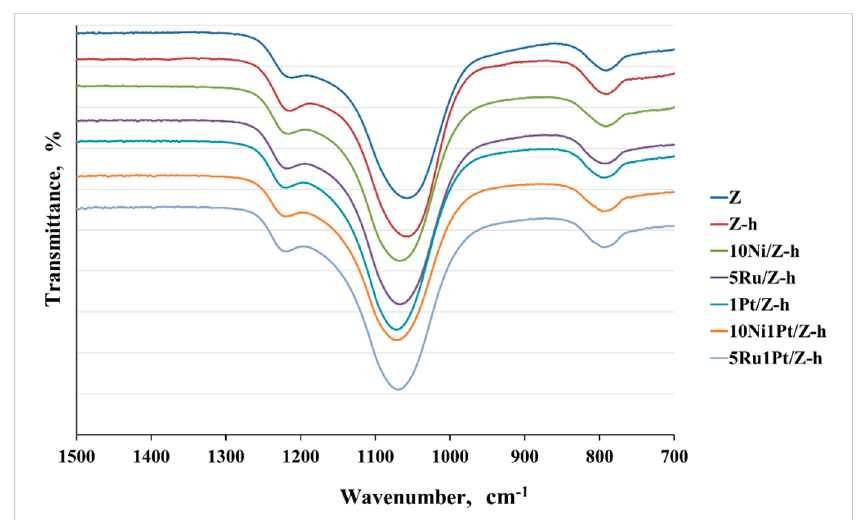
Figure 4. ATR-FTIR spectra of the studied samples. TEM images of the 10Ni1Pt/Z-h sample show the presence of NiO and Pt nanopar-